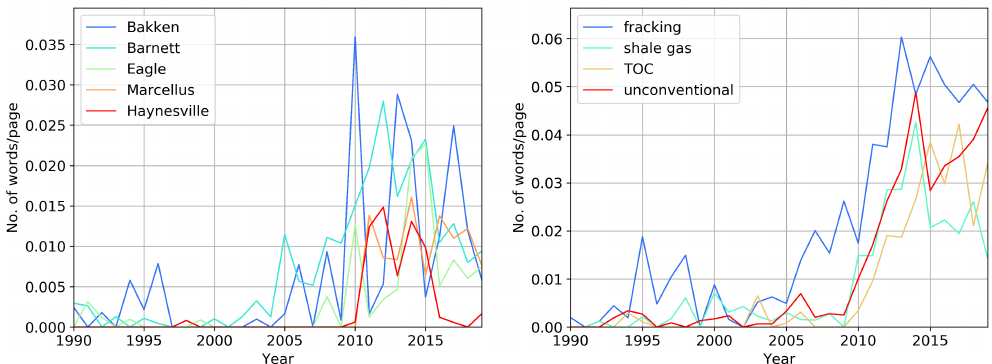
Figure 8. Most frequently mentioned shale plays, and change in frequency of “hydraulic fracturing” and “shale gas.”